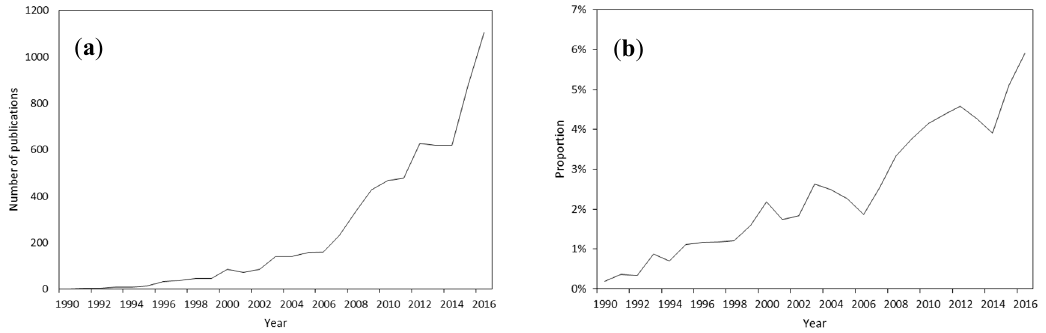
Figure 3. Trends in publications of social robotics. ( a ) By number of articles; ( b ) proportion in relation to all-robotics research.